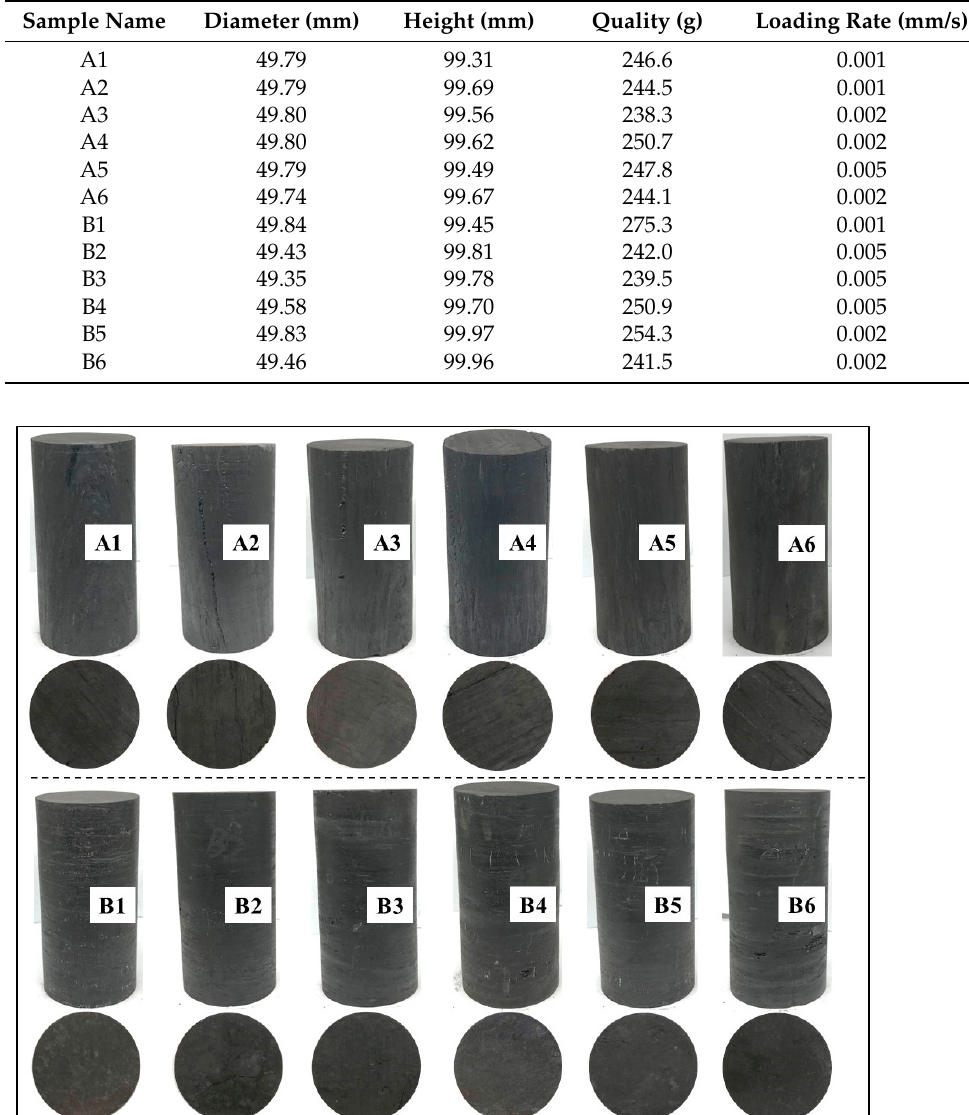
Table 1. Basic information on the bituminous coal samples.